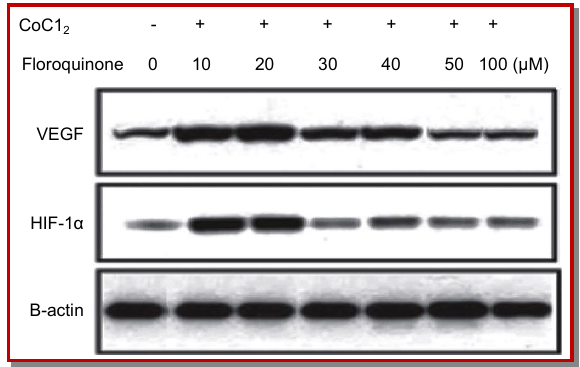
Figure 3: Floroquinone treatment of HOTHC cell lines inhibits angiogenesis. The cells after exposure to CoCl 2 were incubated with floroquinone for 48 hours and then analyzed for HIF-1 α and VEGF expression using Western blot assay and immuno-